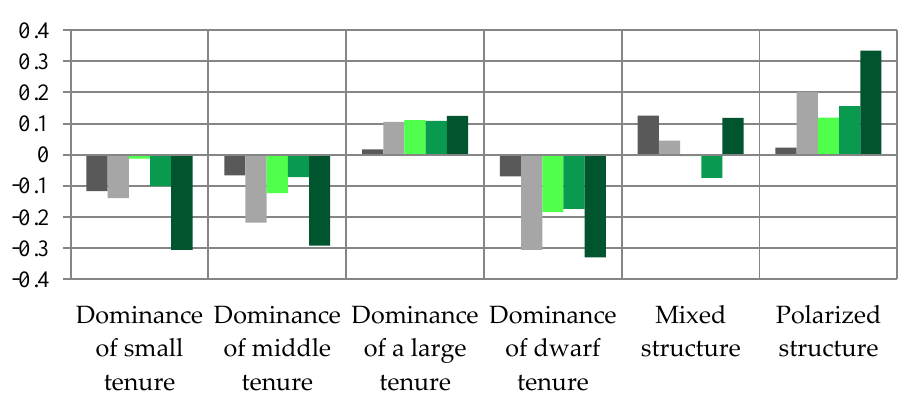
Figure 3. Changes in the difference of settlement clusters in each dimension (average values).